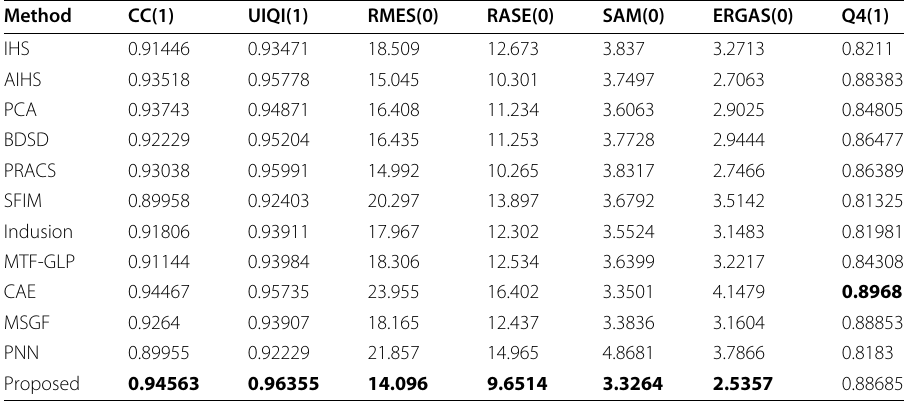
Table 2 Numerical results of the full reference QuickBird-1 dataset